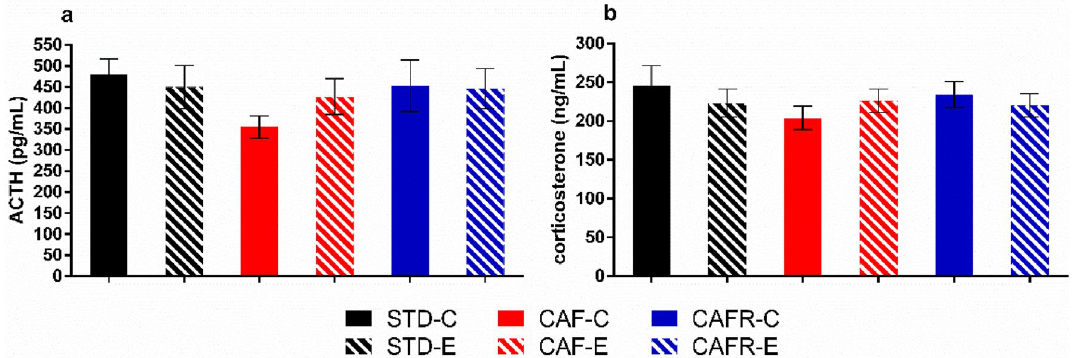
Figure 5. Effect of dietary interventions and exercise on HPA-axis hormone response to the Hole Board test. ( a ) Plasmatic ACTH levels (ng/mL) and ( b ) corticosterone levels (ng/mL) in response to exposure to a novel environment.